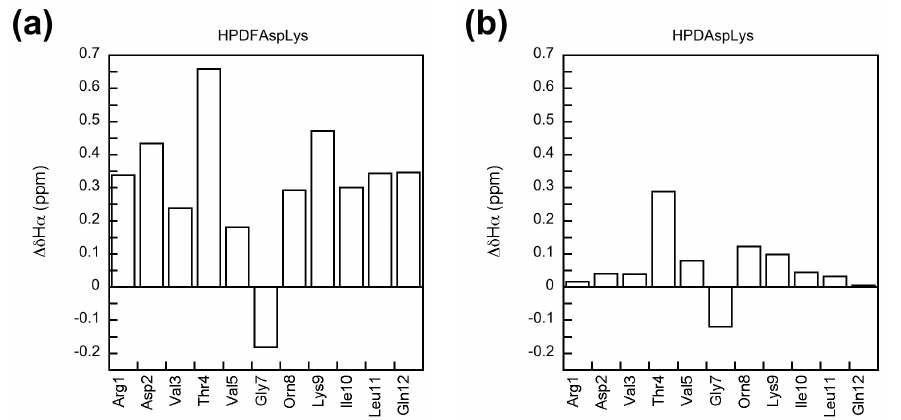
Figure 2. The chemical shift deviation ( ∆ δ H α ) for the residues in peptides HPDFAspLys ( a ) and HPDAspLys ( b ). Table 2. The average 3 J NH α coupling constant values for the strand residues in the HPDFZbbXaa, HPDZbbXaa, and HPDUZbbXaa peptides 1 .